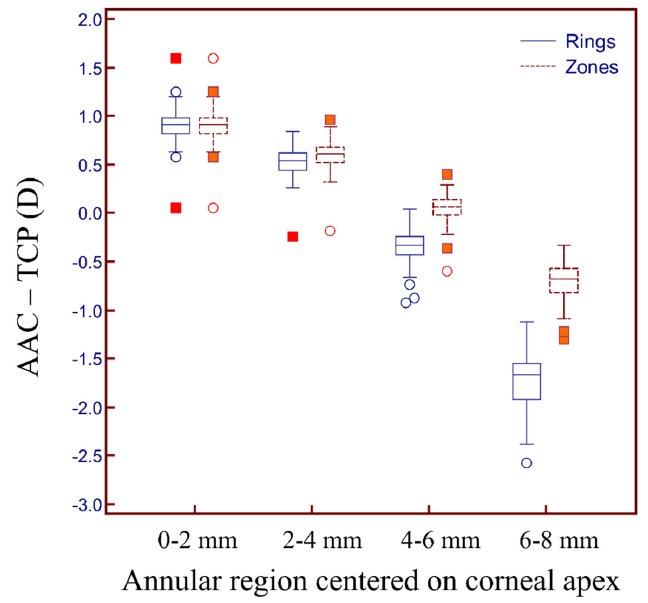
Figure 4. Box and whisker plot of AAC and TCP difference for rings and zones in different annular regions.